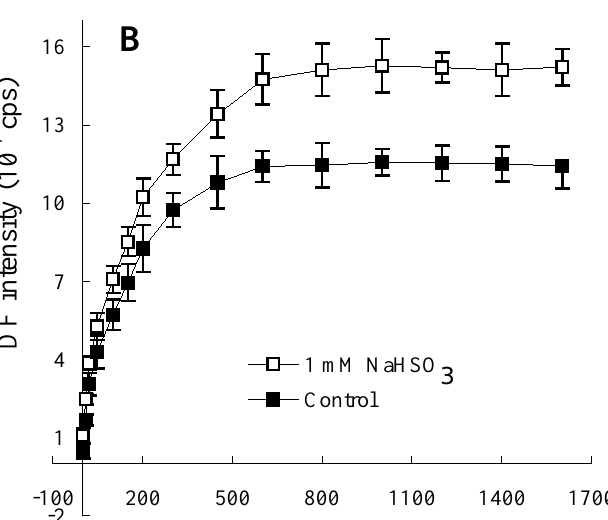
concentration for 72 h. In the figure each value is 3